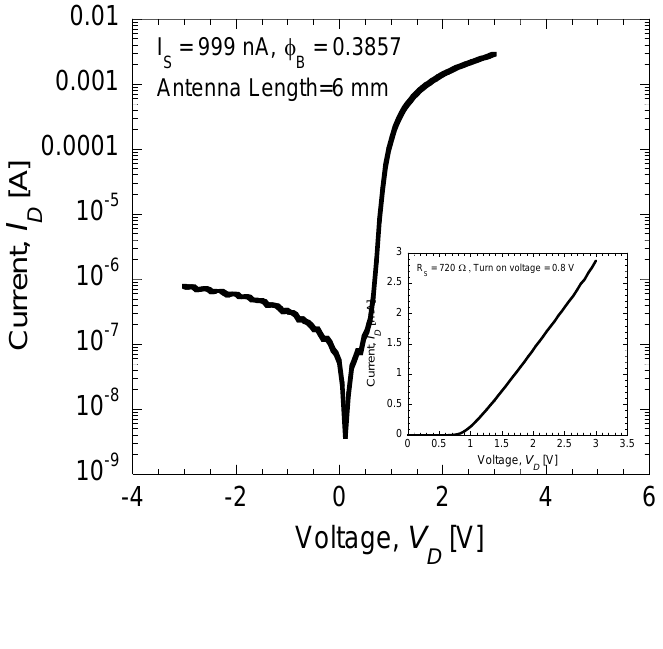
Figure 3. DC I-V characteristics of the fabricated on-chip Schottky